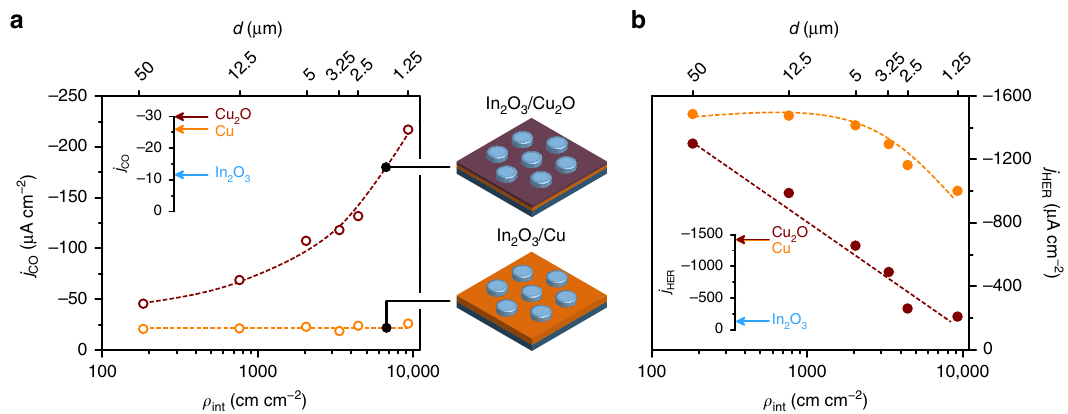
Fig. 2 Catalytic activity for CO and H 2 evolution over structured In 2 O 3 /Cu 2 O and In 2 O 3 /Cu electrodes. Partial current density for a CO ( j CO ) and for b H 2 ( j HER ) in eCO 2 RR electrolyses as a function of the interfacial density ( ρ int ) over In 2 O 3 /Cu and In 2 O 3 /Cu 2 O structured electrodes. The corresponding island diameter ( d ) is also indicated and the trendlines are added as a visual aid. The reaction was carried out in CO 2 -saturated 0.1 M KHCO 3 (pH 6.7) at − 0.6 V vs. RHE. The insets indicate the corresponding partial current densities measured over the single-phase control samples